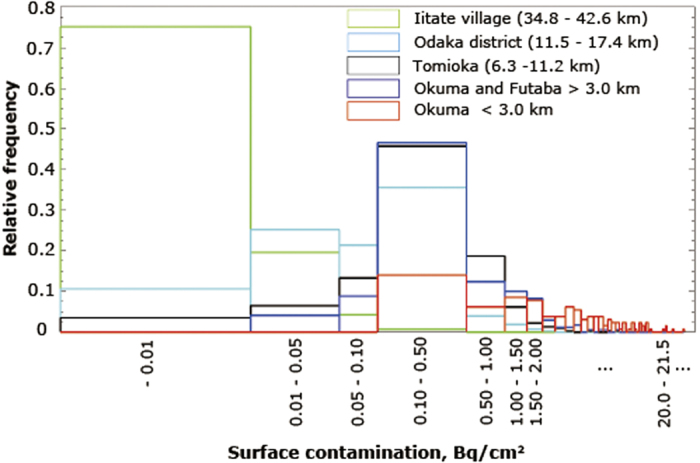
Relative frequency distribution of surface contamination for all samples collected in rooms for each area of Iitate village, Odaka district, Okuma and Futaba, and Tomioka.The distance from the FDNPP is indicated in parenthesis.